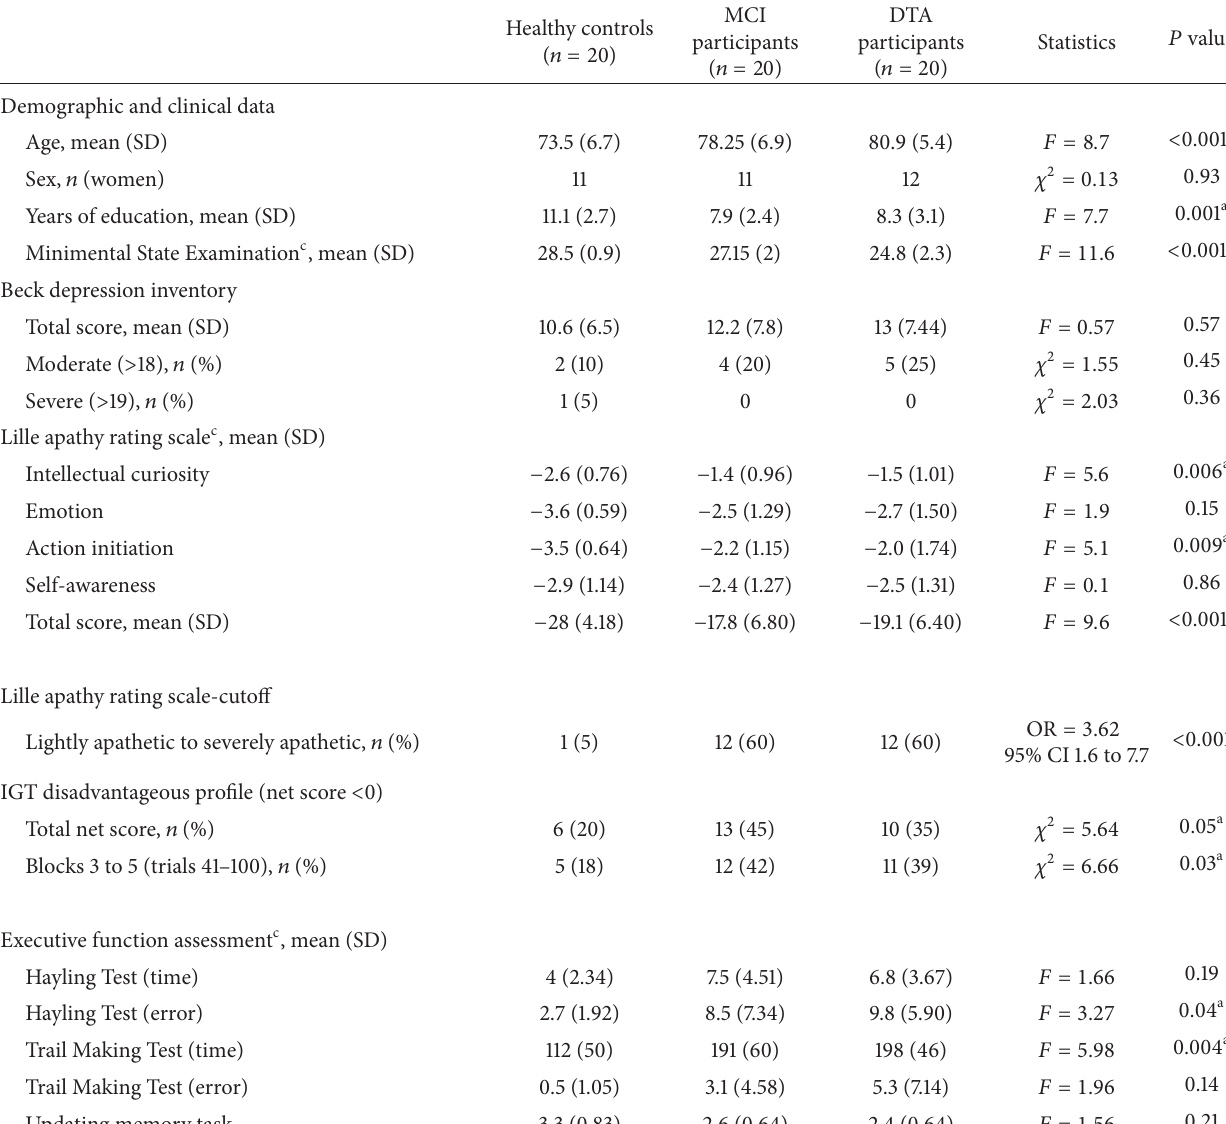
Table 1: Demographic and clinical characteristics and Lille Apathy Rating Scale rates for AD and MCI participants and controls.